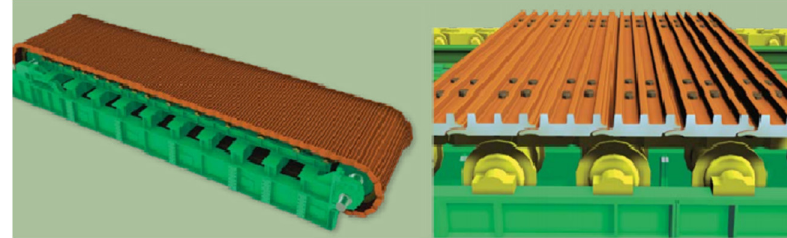
Figure 5. Conveyor belt [25].